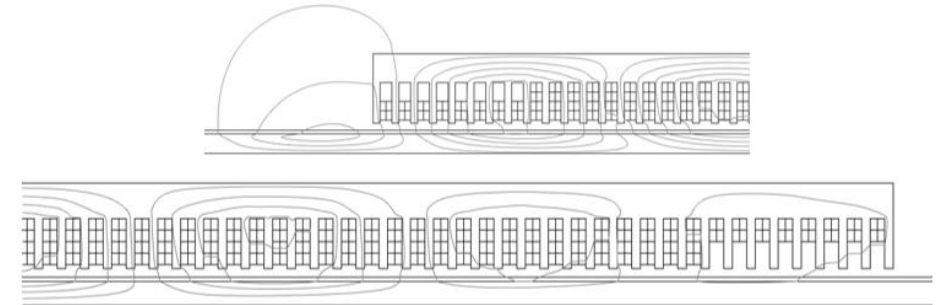
Figure 11. Magnetic field distribution within the LIM [70].